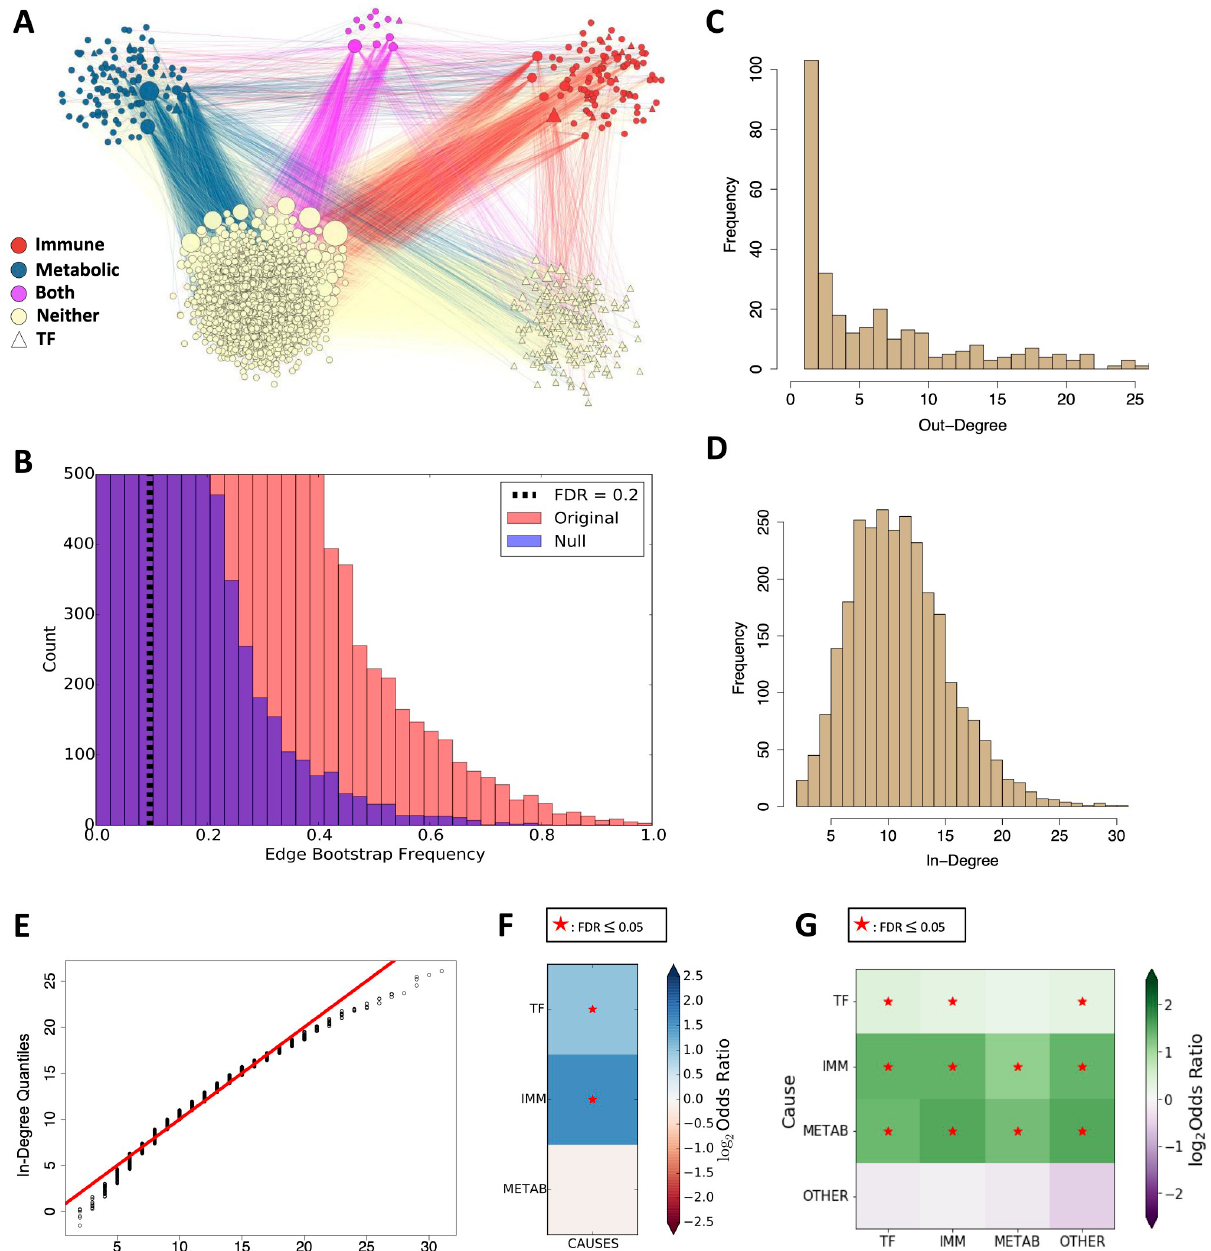
Fig 3. Causal network inferred from glucocorticoid receptor data. A) Causal network clustered by gene type . Edge color indicates the type of the causal gene: red edge indicates an immune causal edge, blue edge indicates a metabolic causal edge, purple edge ( both ) indicates an immune and metabolic causal edge, and tan edge indicates a neither immune nor metabolic other causal edge. B) Significance thresholding for edges , based on the null distribution of selection frequencies. C) Out-degree distribution of network . For clarity, several high out-degree values with low frequencies are not shown. D) In-degree distribution of network . E) Quantile-quantile (Q-Q) plot of in-degree distribution against normal quantiles . The in- degrees have a heavier left tail and lighter right tail than the normal distribution. F) Enrichment of gene classes among network causal genes , measured by odds ratio. G) Enrichment of edge classes among network edges , measured by odds ratio. See also S6 Table.